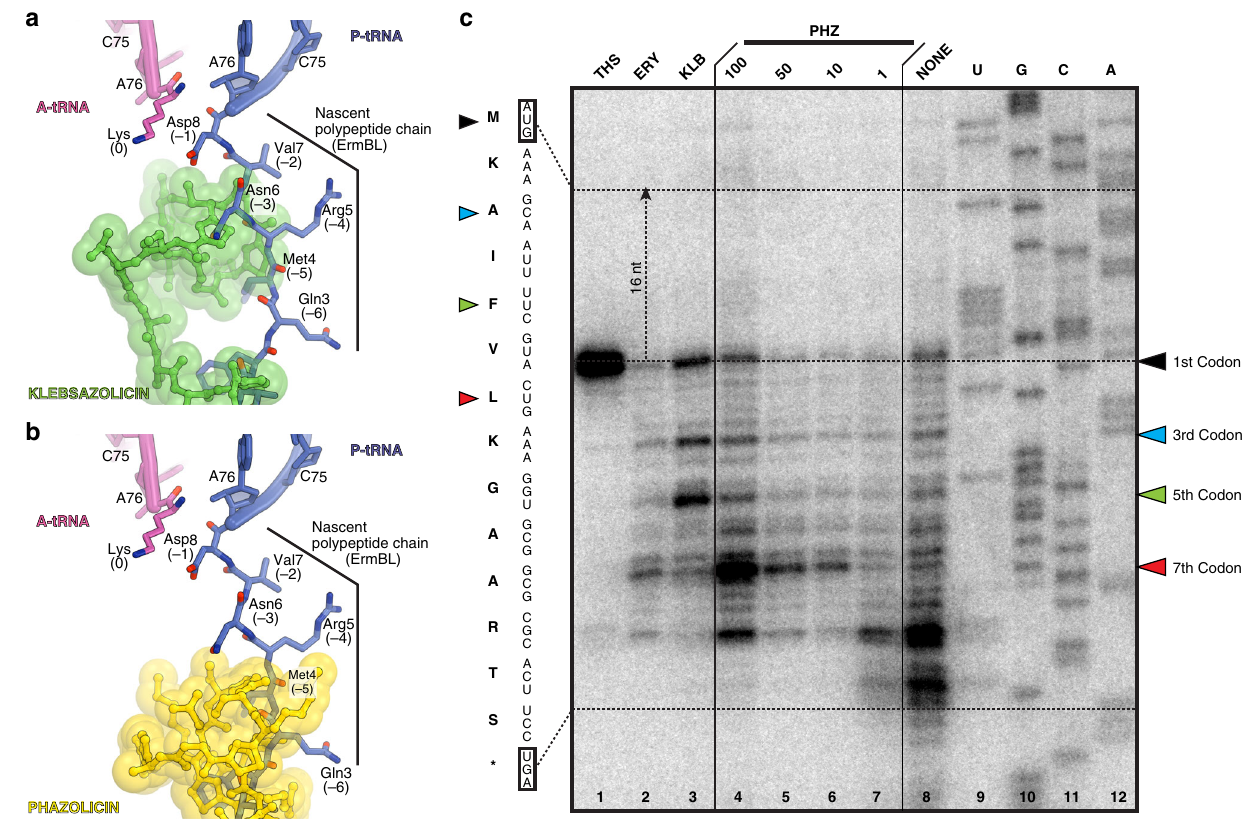
Fig. 4 PHZ inhibits the elongation step during protein synthesis. a , b In silico modeling of the nascent polypeptide chain in the ribosome exit tunnel in the presence of klebsazolicin ( a , PDB entry 5W4K 8 ) or phazolicin ( b , current structure) using the cryo-EM structure of the 70S ribosome with ErmBL peptide bound to the P-site tRNA (PDB entry 5JTE 31 ). c Ribosome stalling by PHZ on trpL- 2Ala mRNA in comparison with other translation inhibitors (thiostrepton, THS; erythromycin, ERY; klebsazolicin, KLB), as revealed by reverse-transcription primer-extension inhibition (toe-printing) assay in a cell-free translation system. trpL- 2Ala mRNA nucleotide sequence and the corresponding amino acid sequence are shown on the left. Colored triangles show ribosome stalling at 1st, 3rd, 5th, and 7th codons. Note that owing to the large size of the ribosome, the reverse transcriptase stops at the nucleotide + 16 relative to the codon located in the